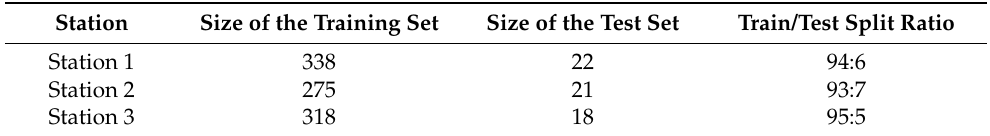
Table 4. Splitting of the labelled dataset into training and test sets for development of the LSTM